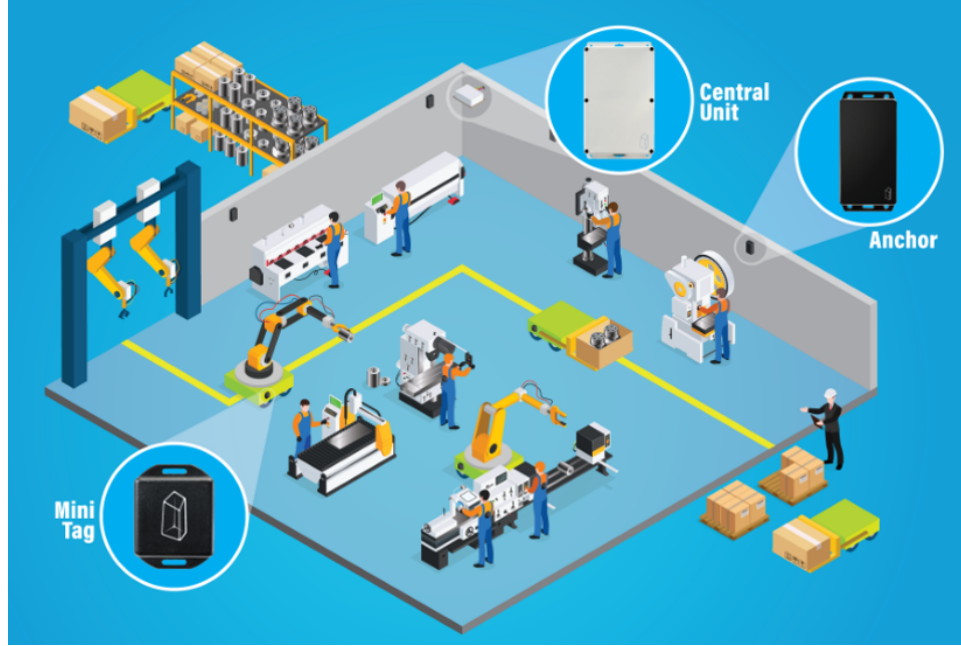
Figure 3. The hardware architecture of the applied IPS (based on Sunstone-RTLS